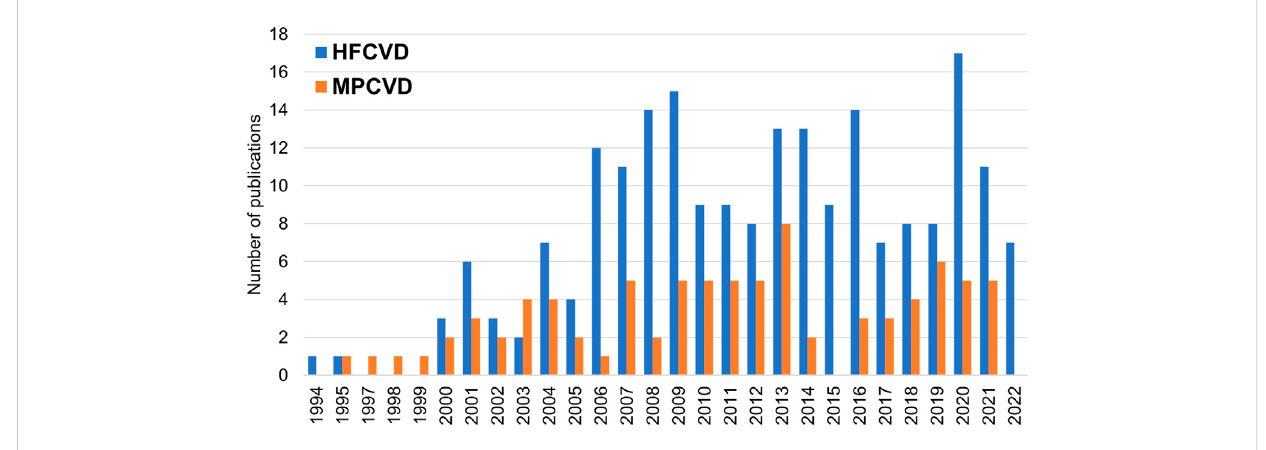
FIGURE 7 Number of publications per year on commercial and in-house BDD anodes, employing HF or MPCVD deposition methods, based on the bibliometric analysis search (source: the